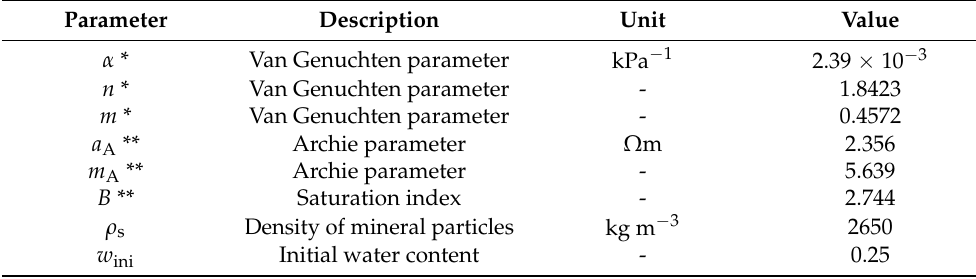
Table 1. Characterisation parameters for the modelled kaolinite.